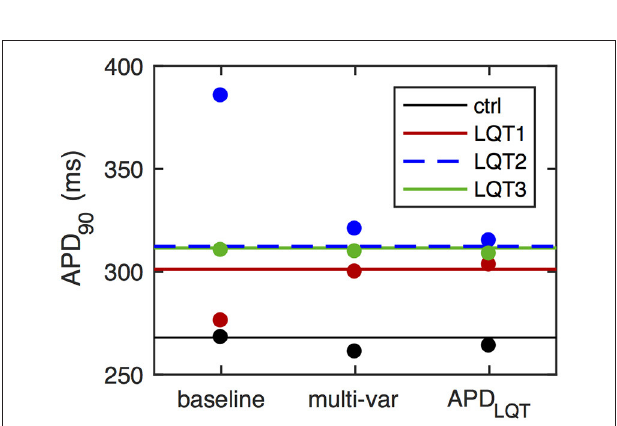
FIGURE 2 | APD values of optimized models. Horizontal lines give control APD 90 (black) as well as APD 90 surrogates for QT interval prolongation in LQT patients (colored). These APD values form the optimization objective in the simplest case (“APD LQT ”). For the multi-variable optimization (“multi-var”), the objective also include constraints on [Ca 2 + ] i and [Na + ] i . Dots give APD 90 values under control simulations (black) and during LQT simulations (LQT1, red; LQT2, blue; LQT3, green). The overestimation of the LQT2 response and the underestimation of the LQT1 response in the baseline ORd model are eliminated in the optimized models. Relative APD 90 prolongation in the